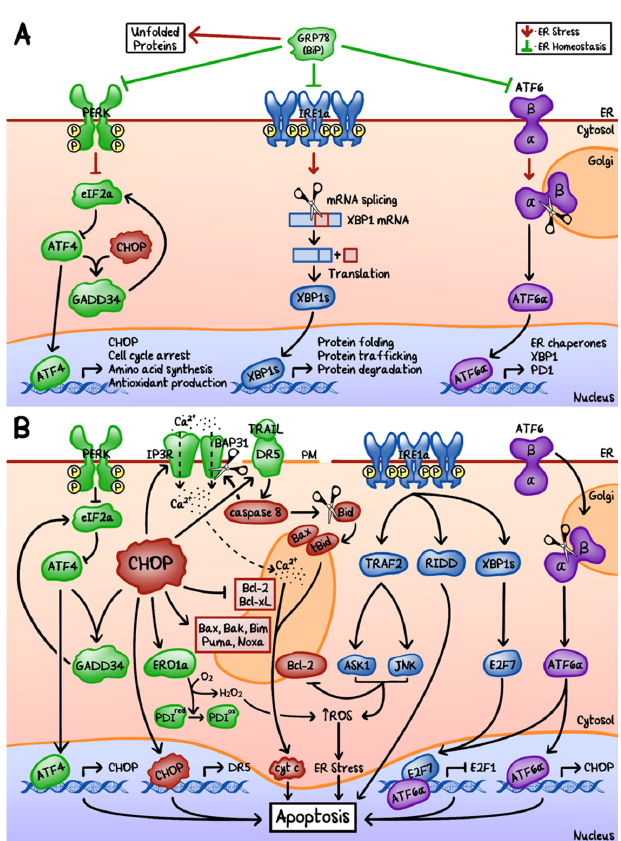
Figure 3. Endoplasmic reticulum (ER) homeostasis, stress, and the unfolded protein response (UPR). ( A ) ER homeostasis is mediated by 78-kDa glucose-regulated protein (GRP78). Under stress conditions, GRP78 dissociates from pancreatic endoplasmic reticulum kinase (PERK), inositol-requiring enzymes 1 α (IRE1 α ), as well as the activating transcription factor 6 (ATF6), leading to activation of their downstream signaling cascades in order to restore ER